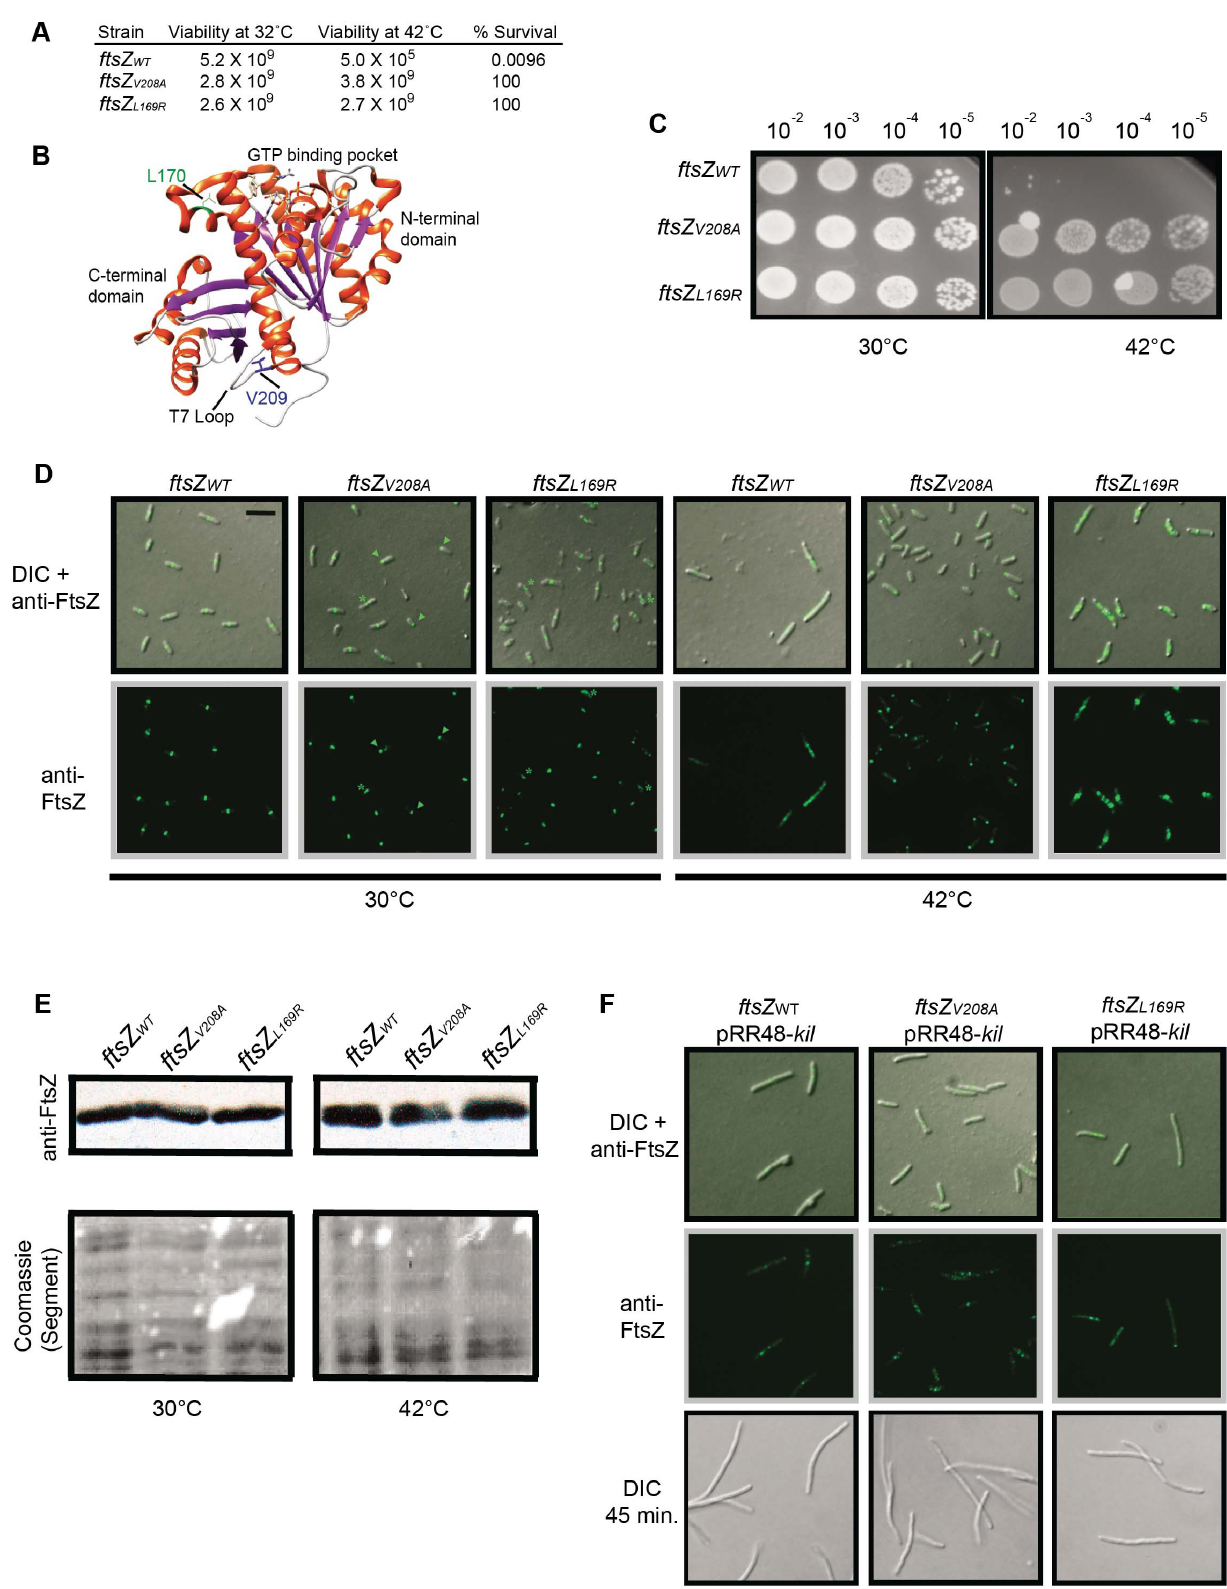
Figure 4. Characterization of Kil-resistant ftsZ alleles. (A) The ftsZ V208A and ftsZ L169R mutants are Kil-resistant alleles. Shown are cfu at 32 u C and 42 u C and resulting survivor frequencies (cfu/mL at 42 u C divided by cfu/mL at 32 u C) for kil -expressing strains with ftsZ WT , ftsZ V208A , or ftsZ L169R . (B) Location of L170 and V209 in the crystal structure of Pseudomonas aeruginosa FtsZ [92], corresponding to L169 and V208 of E. coli FtsZ, generated by